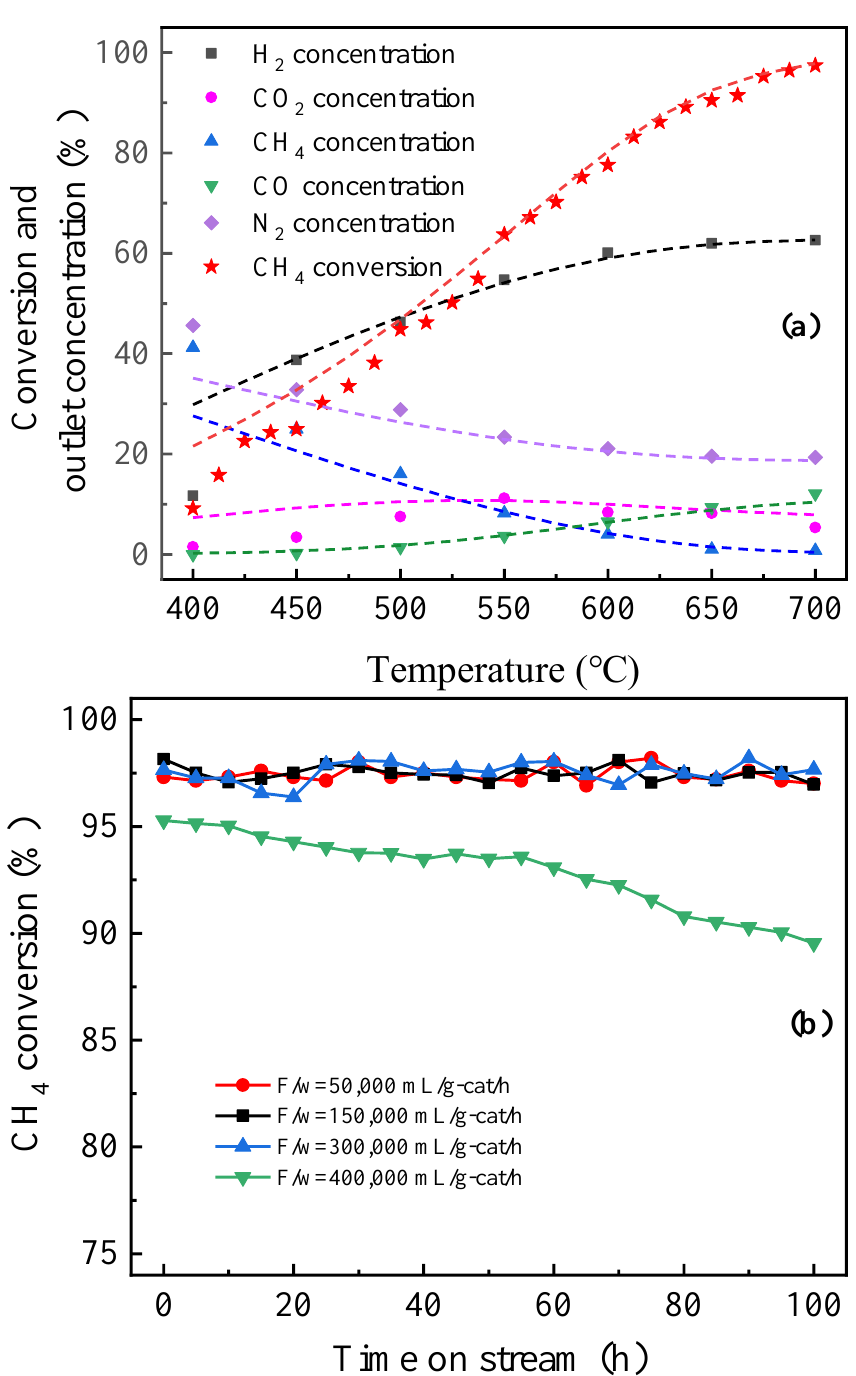
Figure 7. ( a ) SRM activity obtained on anodic alumina catalysts (dashed lines are thermodynamic equilibrium data, F/w = 150,000 mL/g-cat/h); ( b ) catalyst stability at different space velocities.